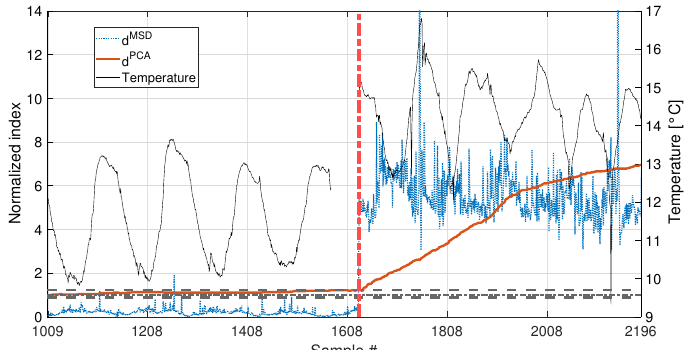
Figure 24. Comparison between d MSD (blue dotted line) and d PCA (red solid line), with b = 1008, for added mass equal to 3% of the total mass. A black thin line identifies the